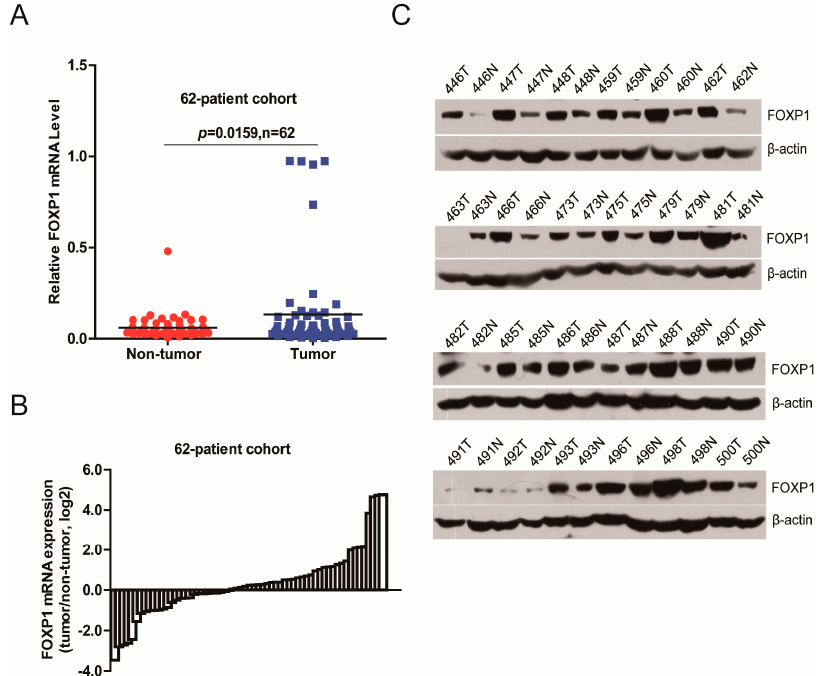
Figure 1. Forkhead box P1 (FOXP1) expression in hepatocellular carcinoma (HCC) clinical samples. ( A ) FOXP1 mRNA levels in the 62-patient cohort; ( B ) The fold change of FOXP1 levels in paired tumor/non-tumorous tissues of the 62-patient cohort; ( C ) FOXP1 protein levels in 24 pairs of HCC tissues (T) and their corresponding adjacent noncancerous tissues (N).